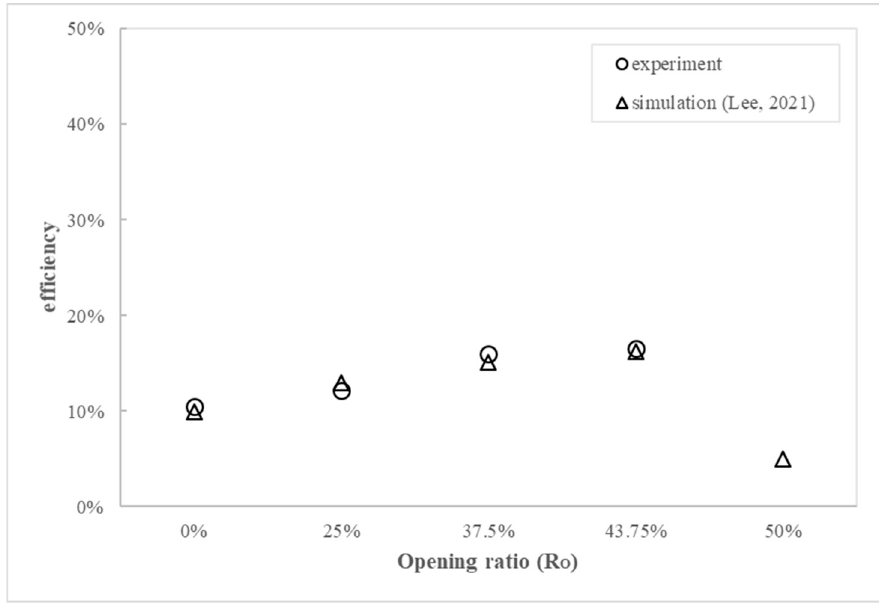
Figure 23. Comparison for the converting efficiency from the OWC with various opening ratios.